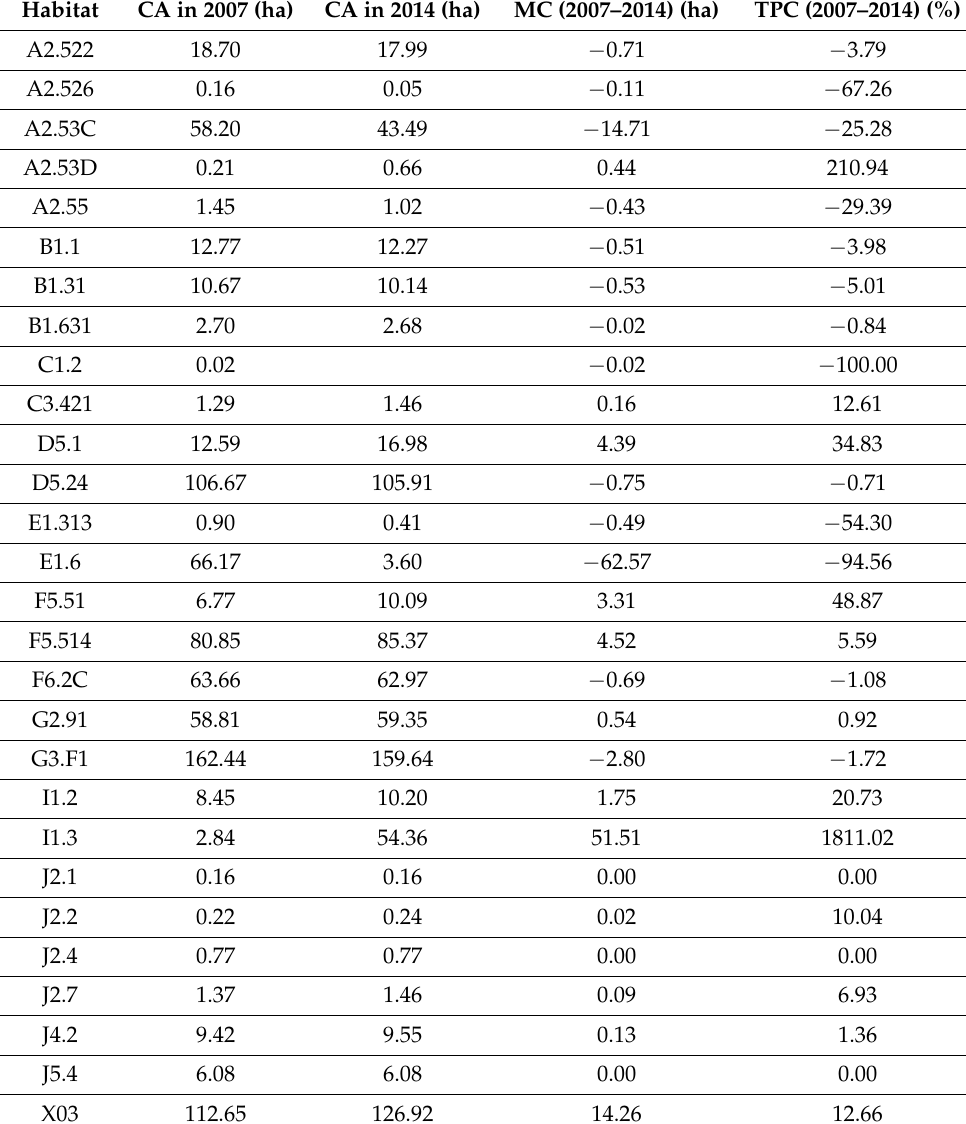
Table 4. CA in 2007 and 2014: MC and TPC in the CE site. Habitat CA in 2007